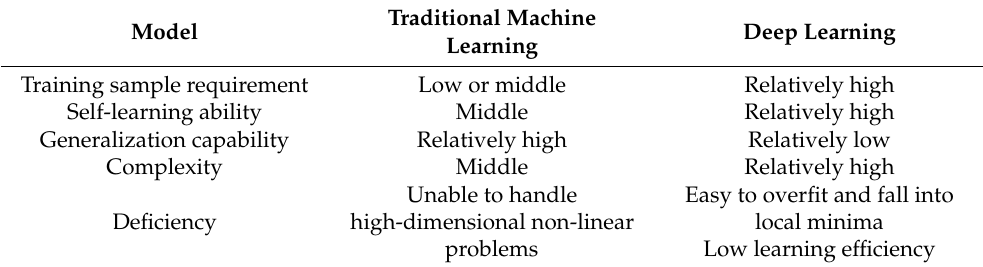
Table 3. Comparison for traditional machine learning and deep learning models. Traditional Machine Model Deep Learning Learning Training sample requirement Low or middle Relatively high Self-learning ability Middle Relatively high Generalization capability Relatively high Relatively low Complexity Middle Relatively high Unable to handle Easy to overfit and fall into Deficiency high-dimensional non-linear local minima problems Low learning